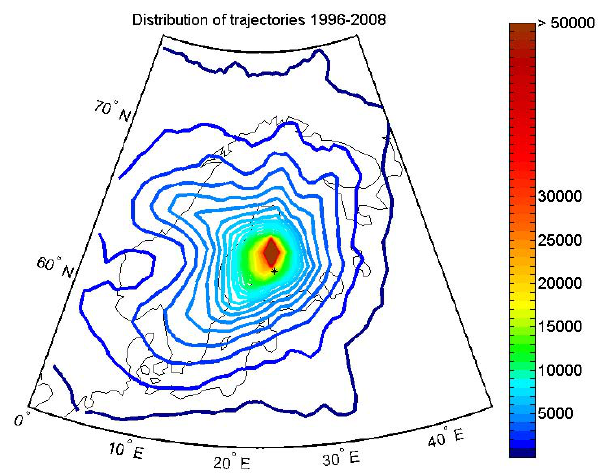
Fig. 1. The distribution of trajectories 1996–2008. The amount of hourly trejectories having passed each grid cell is shown with coloured contour